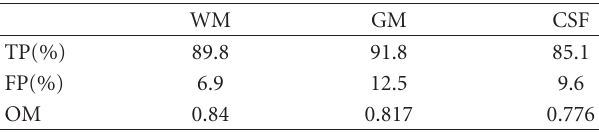
Table 1: Di ff erent validation metrics for a simulated brain data of T 1 -weighted